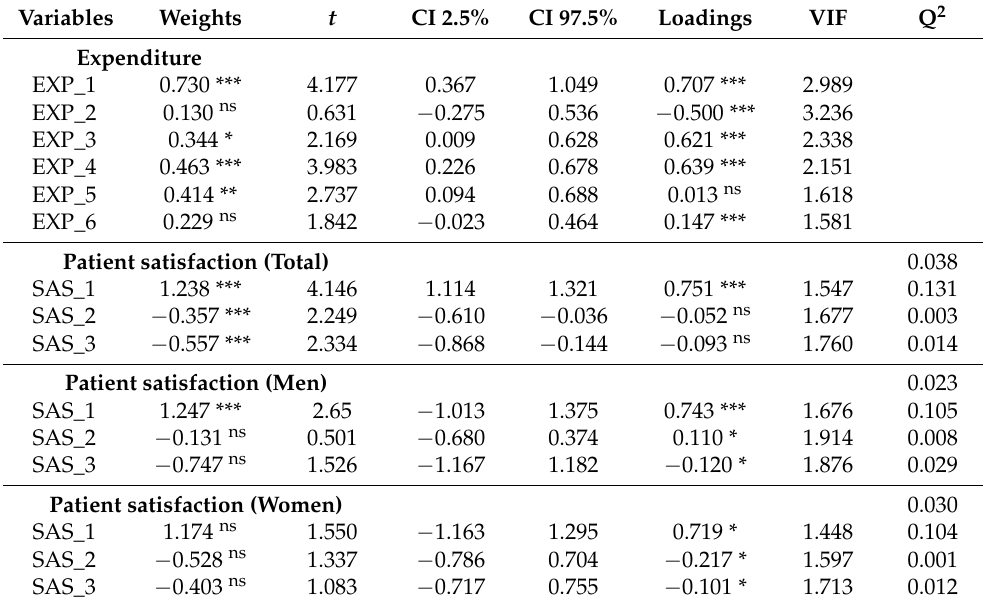
Table 5. Assessment of the measurement model. Estimated constructs in Mode